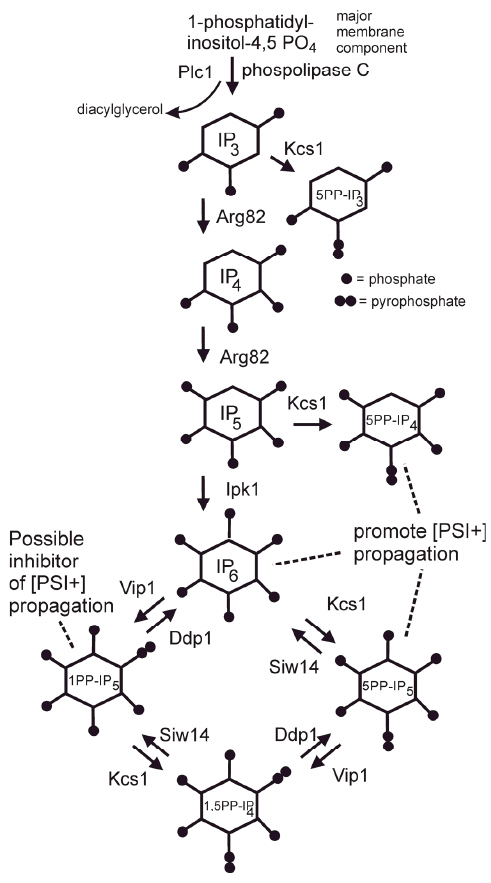
Figure 2. Inositol poly/pyro phosphate metabolism. On this diagram of the inositol polyphosphate biosynthesis pathways, the species that promote [PSI+] propagation are indicated [74]. Overproduction of 1-pyrophospo-inositolpentaphosphate (1-PP-IP5) inhibits [PSI+] propagation [74]. The mechanism by which the inositol pyro/polyphosphates affect prion propagation are unknown. Figure from [34].